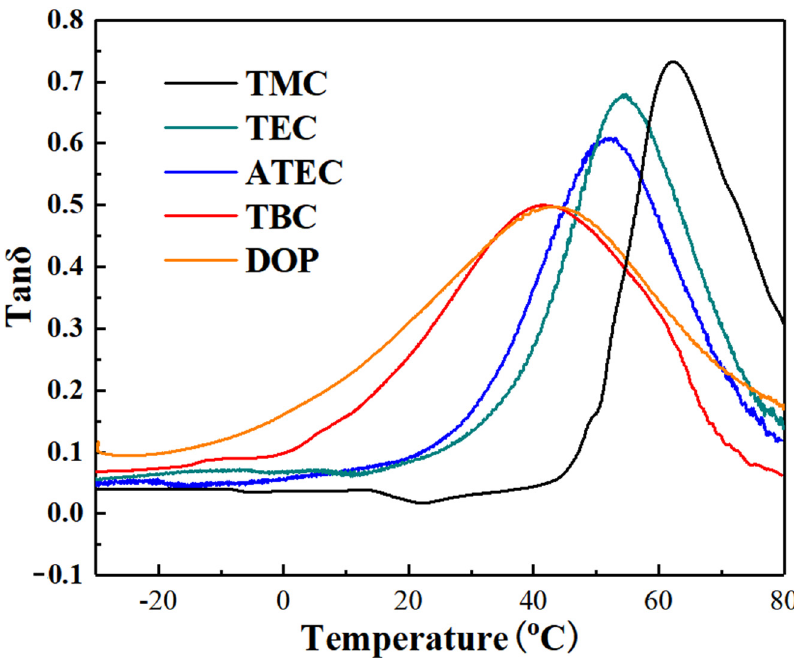
Figure 6. The curves of the tan δ of PVC with Zn(Arg) 2 plasticized by citric acid esters or DOP. For studying the compatibility between the different plasticizers and Zn(Arg) 2 , the migration ratio of the Zn(Arg) 2 versus time in PVC samples was recorded, as shown in Figure 7. The migration ratio of Zn(Arg) 2 in the TBC plasticized PVC sample is the lowest, with an initial migration ratio of 0.48%, and migration ratio after 40 days is only 1.20%. The migration resistance of Zn(Arg) 2 in the TEC and ATEC plasticized PVC is also better than that of PVC with DOP. The migration ratio of Zn(Arg) 2 in PVC with TEC and ATEC increased from 0.87% to 0.91%, and gradually increased to 1.50% and 1.56% in 40 days, while the migration ratio of Zn(Arg) 2 in PVC with DOP varied from 1.18% at 0 days to 2.41% at 40 days. The migration ratio of Zn(Arg) 2 in the PVC plasticized by TMC is the highest, rising from the initial 0.87% to 4.15%, which means that the compatibility between TMC and Zn(Arg) 2 is poor. As a result, the compatibility between TBC and Zn(Arg) 2 is best, leading to the low migration rate of Zn(Arg) 2 in PVC. As we know, the migration of Zn(Arg) 2 affects the transparency of PVC samples, so the change of the average transmittance at 550–800 nm and haze was characterized over time. The results are shown in Figure 8. As shown in Figure 8A, the transmittance of the two PVC samples with ATEC and TBC maintained a good transmittance (over 90%) for 40 days, which have the highest transmittance and a small decrease in transmittance, better than that of PVC with TEC and DOP. The average initial transmittance of them was 94.27% and 93.50%, which only decreased by 3.95% and 3.11%, respectively, after 40 days. Figure 8B show that, except for TMC, the haze growth trend of the PVC samples with citric acid esters is smaller than that of PVC with DOP, indicating that the three citric acid esters and Zn(Arg) 2 have better compatibility in the PVC matrix. The mechanism may be that they has stronger polarity than DOP, which is close to the Zn(Arg) 2 . So the PVC with TEC, TBC, and ATEC have higher transmittance and lower haze. Among them, the initial haze of the TBC group was only 14.12%, and increased by 2.72% after 40 days, which indicating the TBC has the best compatibility with Zn(Arg) 2 . The results are consistent with the results of migration ratio test.